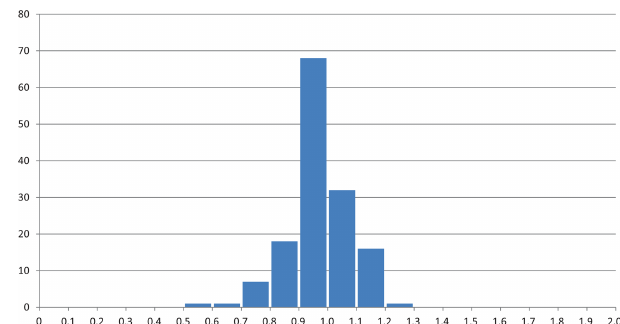
Figure 3. Frequency of occurrence of the factors for the zeolite en- tries 1–144 listed in Table 1 and shown in Fig. 2. (a) Factors cal- culated from polarizability analysis using different electronic po- larizabilities for cations with different coordination numbers (from Table 4 in Shannon and Fischer, 2016). (b) Factors calculated from polarizability analysis using mean electronic polarizabilities from Table